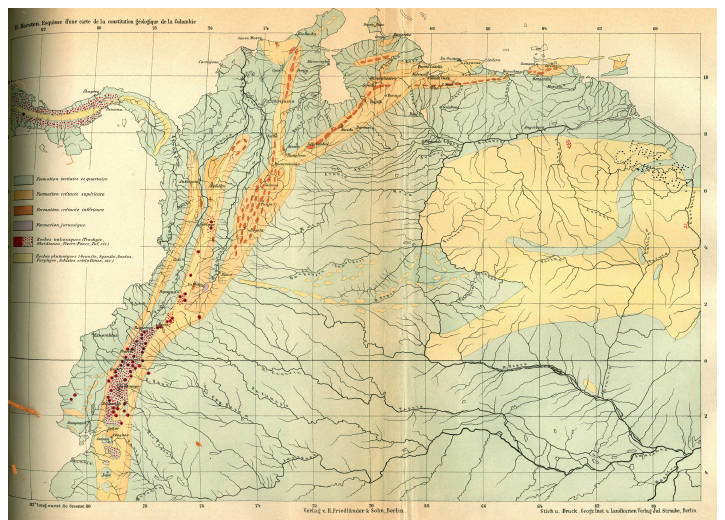
Figure 5. Karsten’s 1886 geologic map of Colombia. Key: light blue – Tertiary and Quaternary, lighter orange/yellow – Upper Cretaceous, darker orange/yellow – Lower Cretaceous, light purple – Jurassic, pink with asterisks – volcanoes, dotted pink – miscellaneous volcanic rocks, yellow – plutonic rocks (granite, syenite, gneiss, porphyry, crystalline schists [sic], etc.).